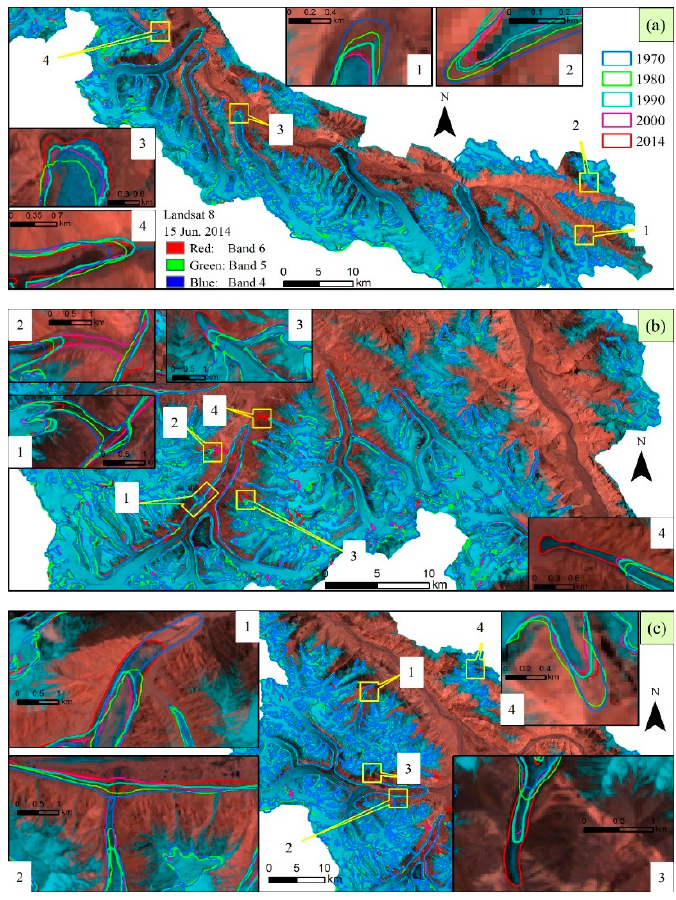
Figure 15. Comparison of glaciers outlines during 1970–2014 in the eastern part ( a ), middle part ( b ) and western part of study area ( c ).